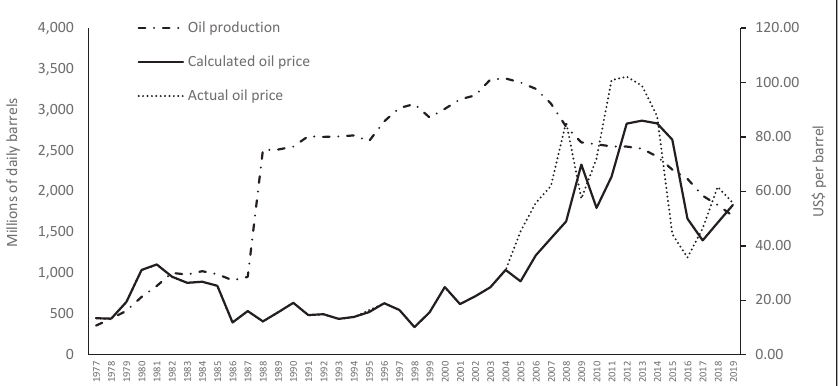
Figure 2. Oil production and